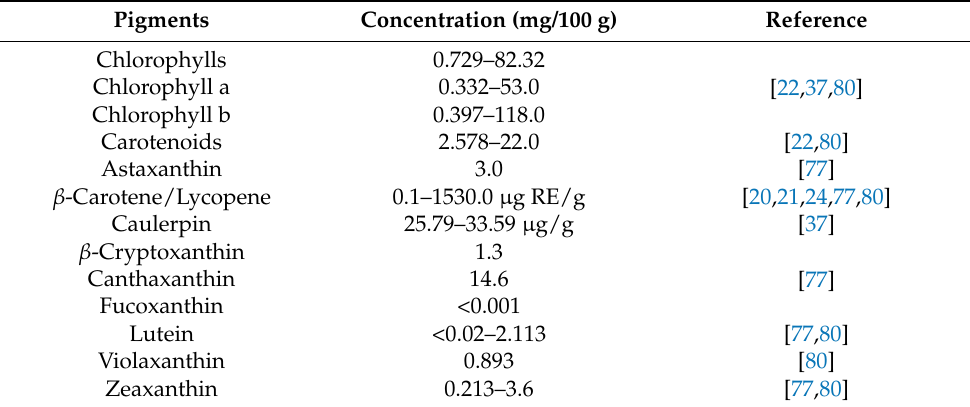
Table 7. The concentration of pigments found in Caulerpa lentillifera